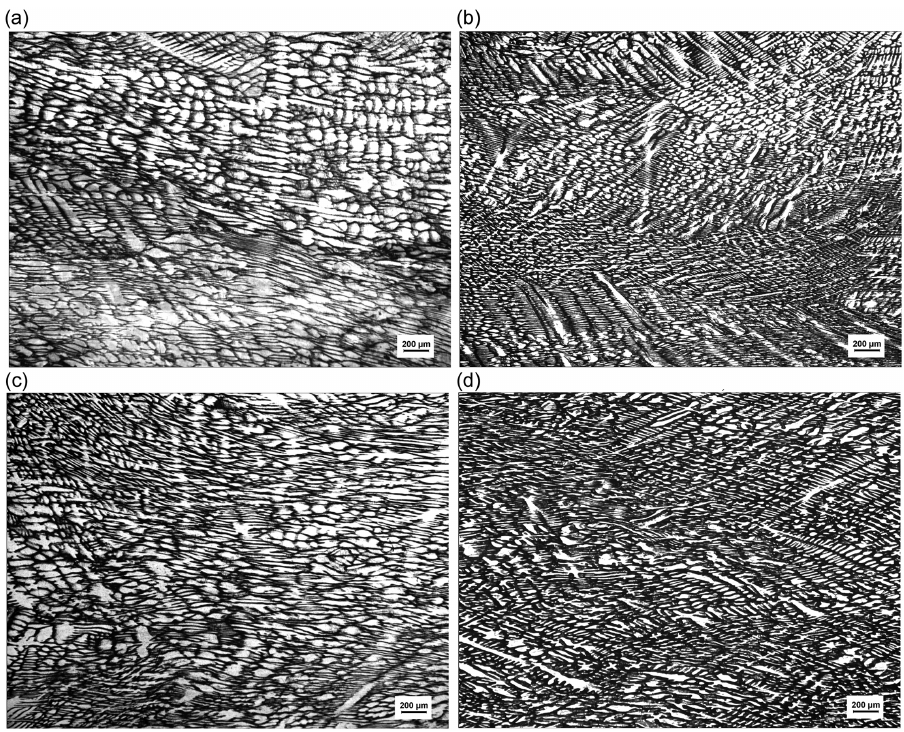
Figure 4: Metallographic microstructure of BFe10-1-2 alloy under the deformation condition of: (a) 1,023 K, 0.001 s – 1 ; (b) 1,123, 0.01 s – 1 ; (c) 1,173, 1 s – 1 ; (d) 1,273, 10 s – 1